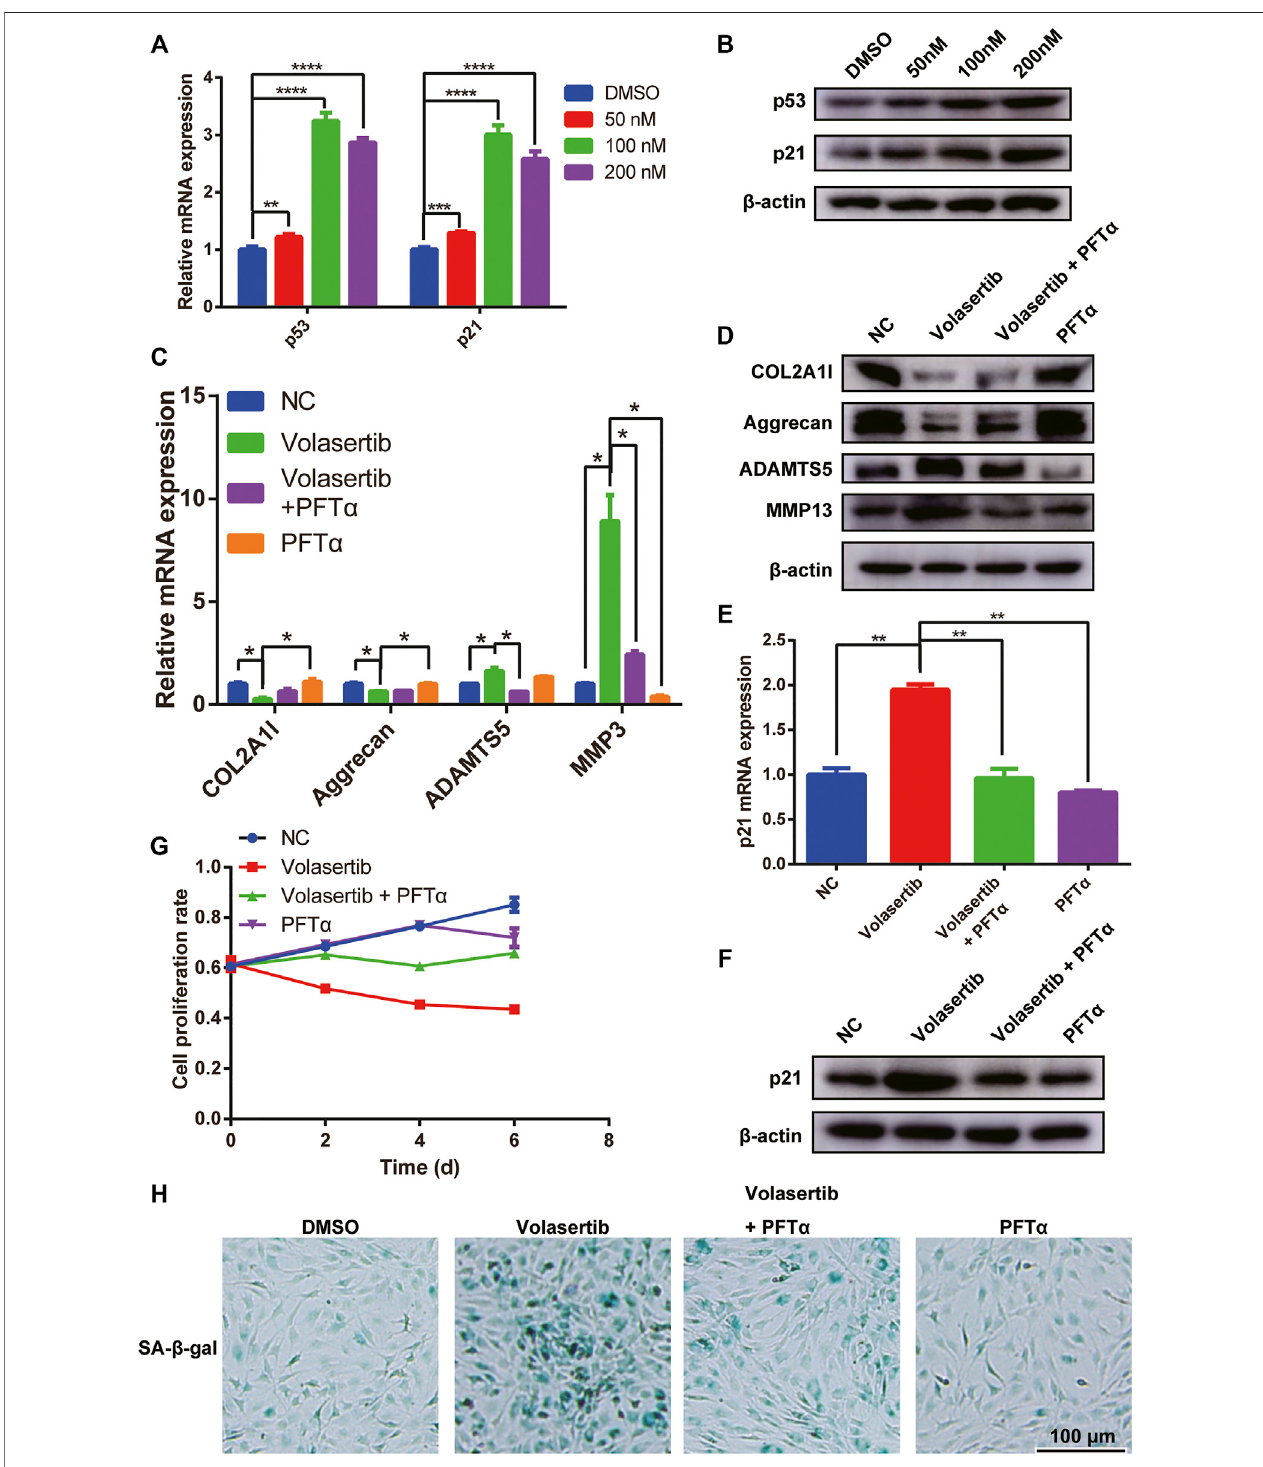
FIGURE 4 | PLK1 inhibition increases the expression of p53 and p21. (A,B) The mRNA and protein expression of p53 and p21 after inhibiting the PLK1 kinase activity. (C,D) ThemRNAandproteinexpressionofcollagen,aggrecan,ADAMTS5,MMP3andMMP13wasdetectedinNPCstreatedwithvolasertiborPi fi thrin- α . (E,F) The expression of p21 was detected in NPCs treated with volasertib or Pi fi thrin- α . (G) CCK8 assay was used to detect cell proliferation at the 0, 2nd, 4th, and 6th day aftertreatmentwithvolasertiborPi fi thrin- α . (H) SenescenceofNPCswasmeasuredbySA- β -GalassayaftertreatmentwithvolasertiborPi fi thrin- α .Allexperiments were performed in duplicates, and data are reported as the mean ± SD. * p < 0.05, ** p < 0.01, *** p < 0.001, **** p < 0.0001. SD, standard deviation.